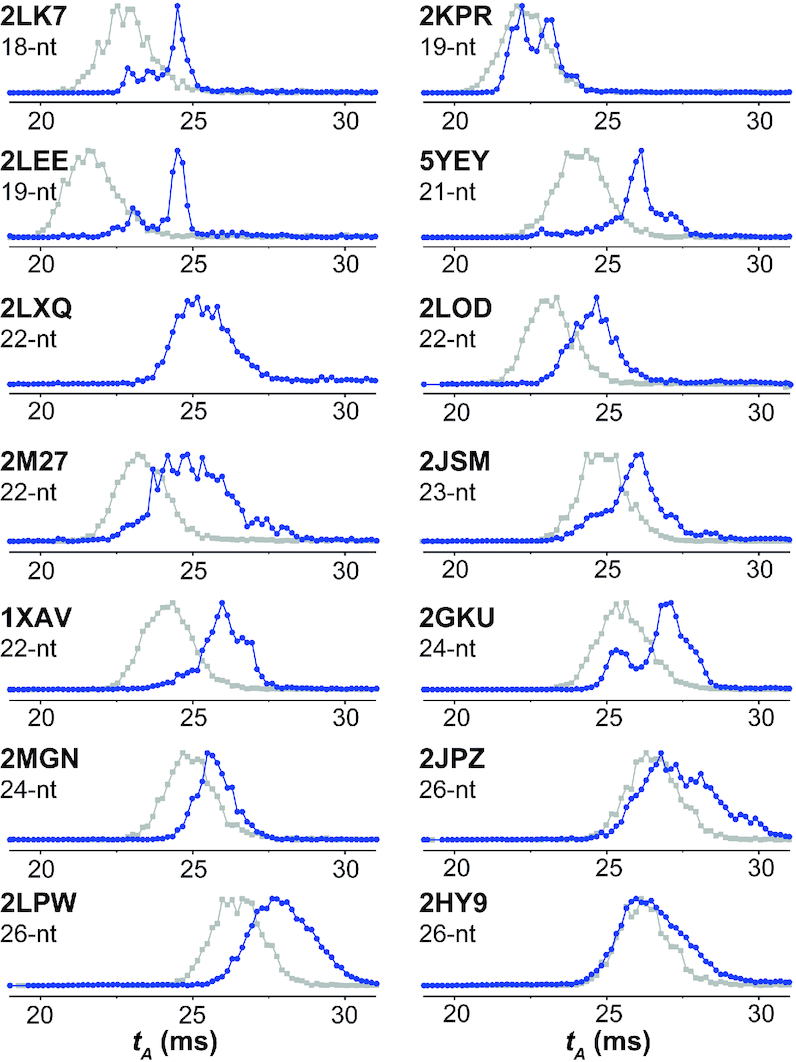
Electrospray ion mobility analysis of the folded form with 2 K+ (blue, recorded from 1 mM KCl and 100 mM TMAA) and the unfolded form with 0 K+ (gray, recorded from 100 mM TMAA) Total arrival time distributions (tA) of the 5– charge states for 0 K+ and 2K+ complex are shown. The left column gathers representative 3-quartet G4s with type-I stacking and the right column gathers all 3-quartet structures with type-II stacking.